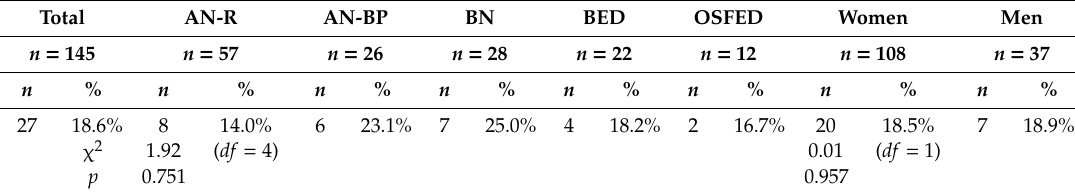
Table 2. Prevalence estimate of A / DA depending on ED subtype and gender.